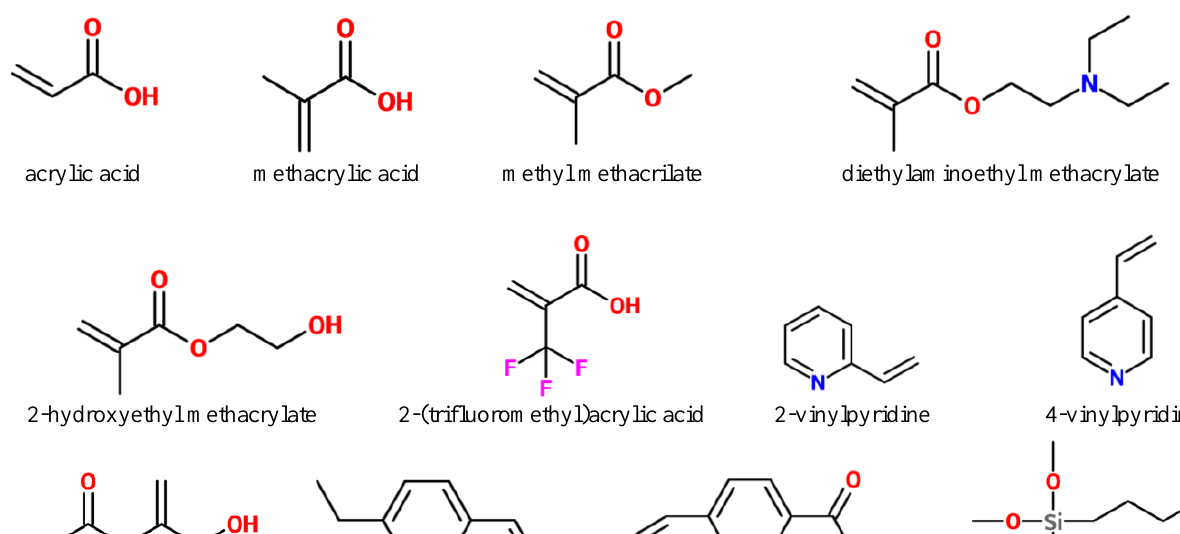
Figure 1. Some functional monomers used in MIP